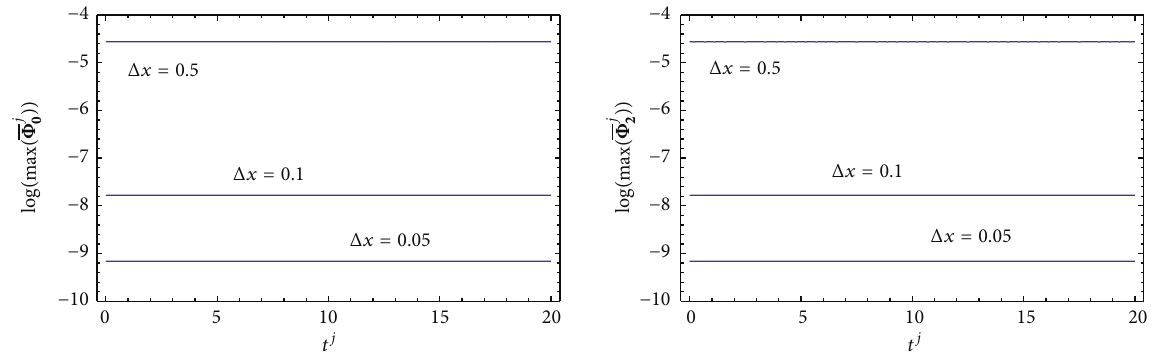
𝑗 ) and log ( max Φ 𝑗 0